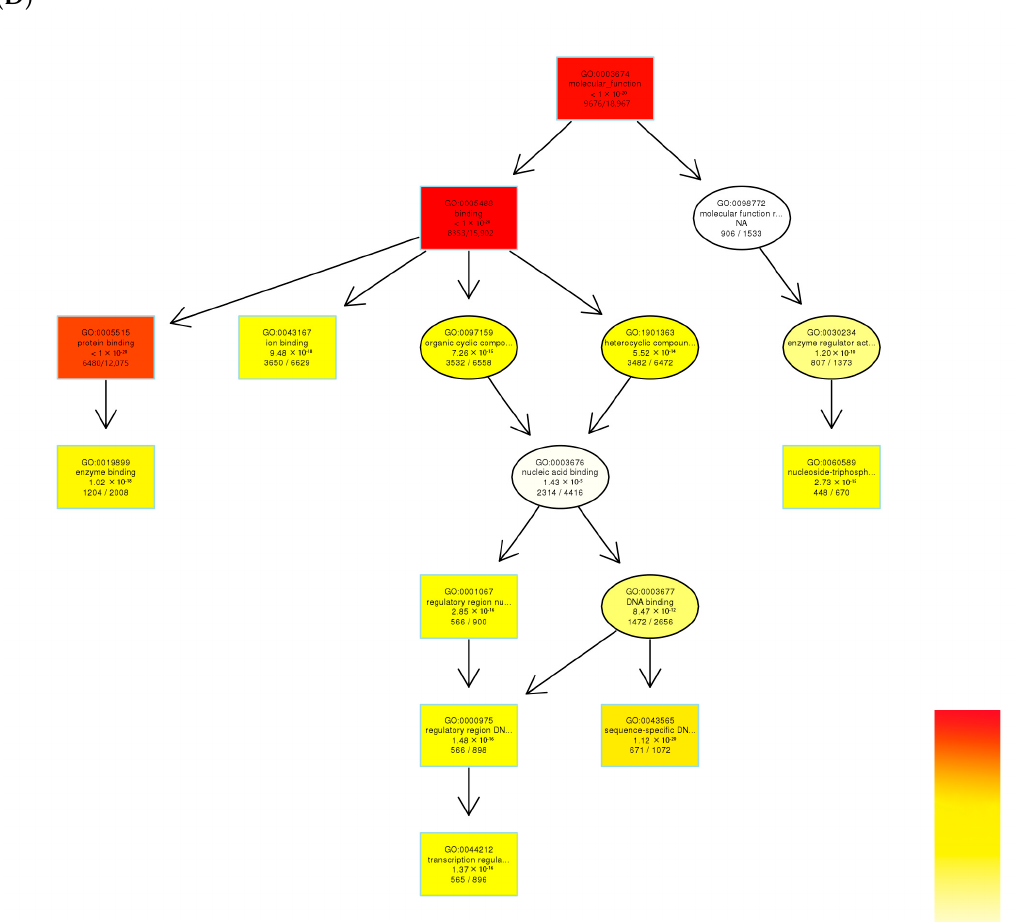
Figure 2. Enriched gene ontology (GO) terms and directed acyclic graphs (DAG). ( A ) The first 20 GO terms. ( B – D ) Directed acyclic graph showing the GO enrichment analysis results of the candidate